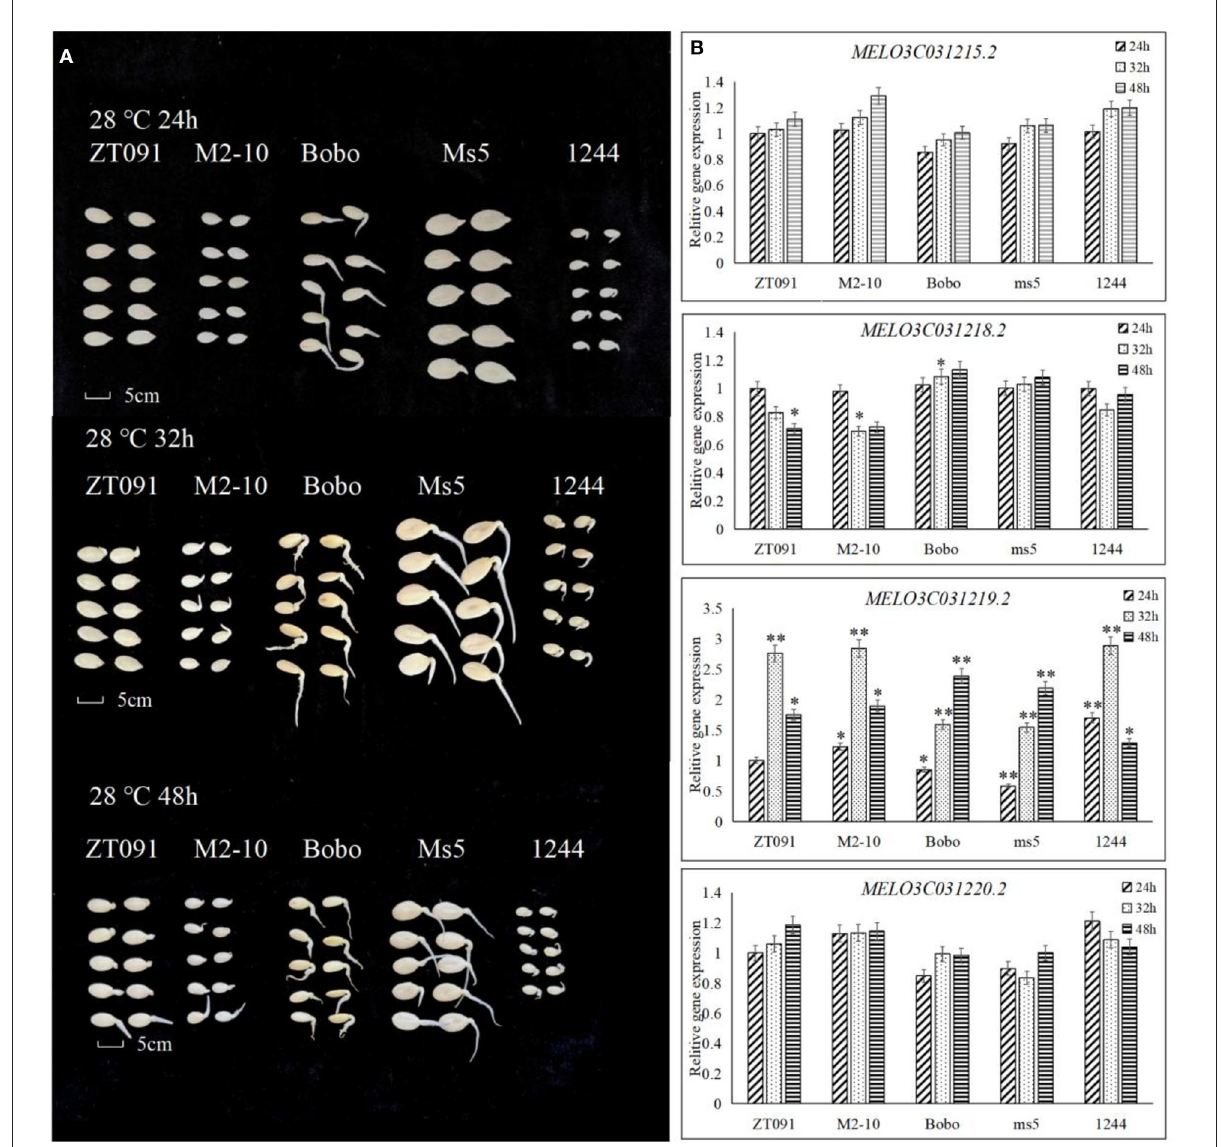
FIGURE6 Performance of the germination of other five melon seeds and candidate gene expression. (A) The seed germination of five melon germplasms under the treatment including a soaking time of 8h with the germinate temperature of 28 ◦ C and the investigated seed germinate rate at 24, 32, and 48h. (B) Gene expression pattern in candidate interval by qRT in different seed germinate stages. * means significant level P < 0.05. ** means significant level P <